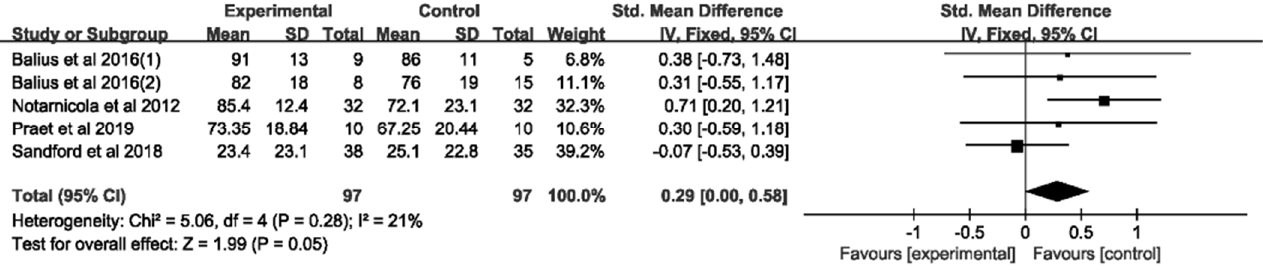
Figure 3. Forest plot of the meta-analysis on functional outcomes. Functional outcomes include VISA-A, SPADI and AHS.